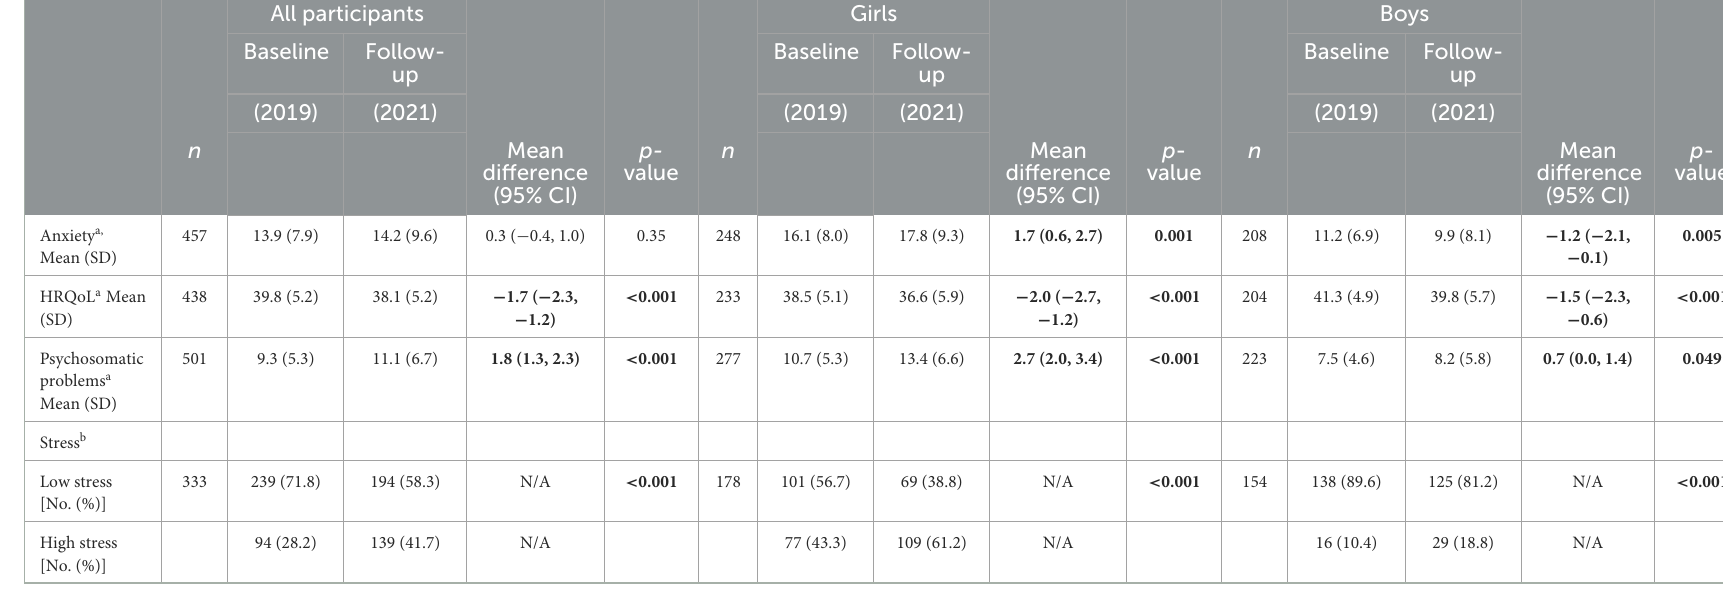
Baseline Follow-